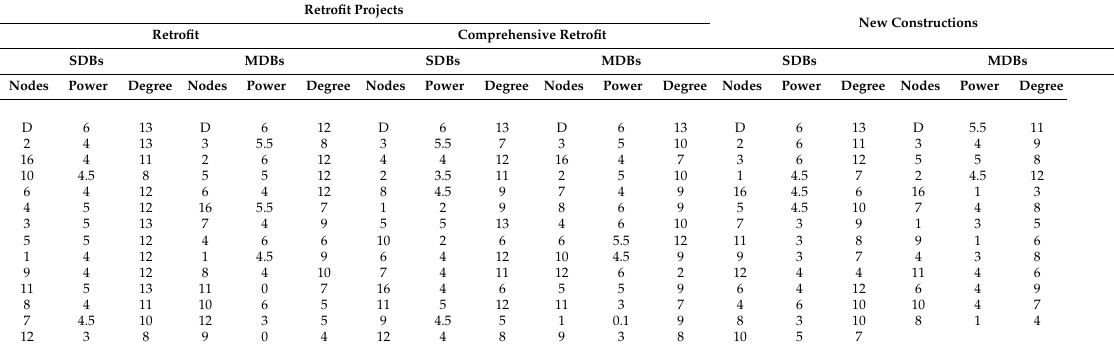
Table A7. Numerical output stakeholder networks classified according to building typologies and project types in France